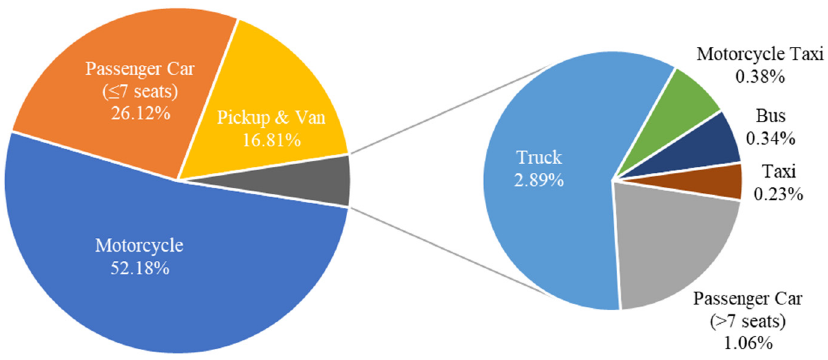
Figure 5. Percentage proportion of various vehicle types.